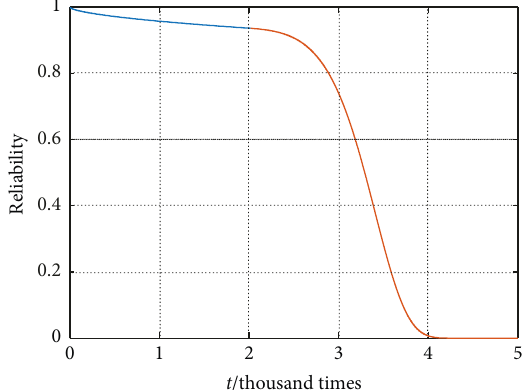
Figure 11: Reliability function curve.